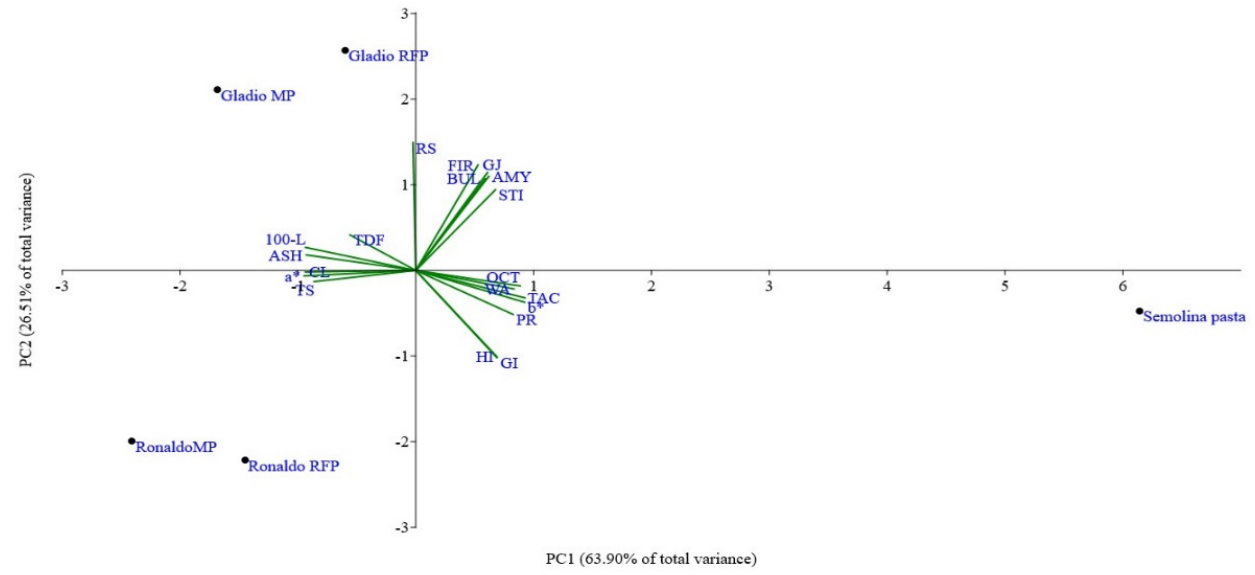
Figure 5. PCA biplot of descriptive analysis of sensory texture parameters: firmness (FIR), bulkiness (BUL), stickiness (STI), global sensorial judgment (GJ); of technological and nutritional parameters: yellow (b*), brown (100-L) and red (a*) indices, water absorption (WA), cooking loss (CL), optimal cooking time (OCT), ash (ASH), total starch (TS), resistant starch (RS), amylose (AMY), protein content (PR), total dietary fiber (TDF), total antioxidant capacity (TAC), hydrolysis (HI), and glycemic (GI) indices, detected in semolina pasta, in micronized pasta (MP) and in refined + F fraction pasta (RFP) from rice cvs Gladio and Ronaldo.